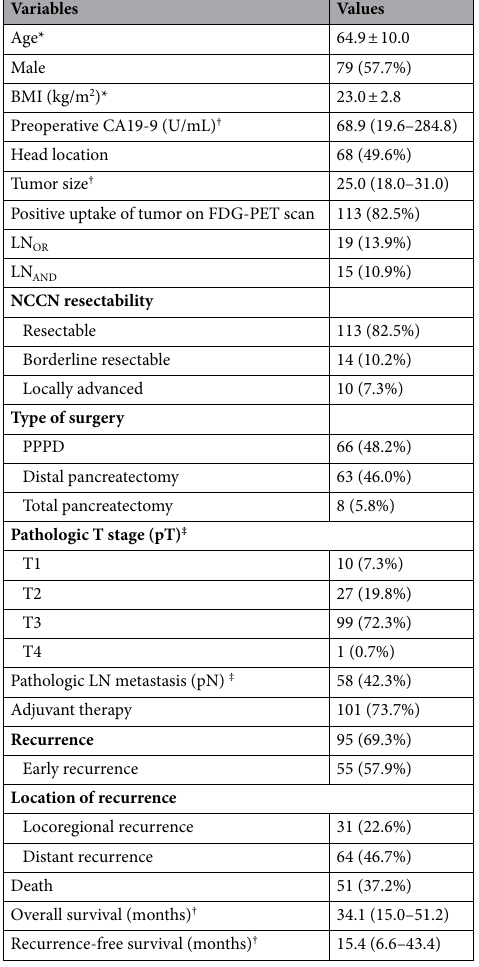
Table 1. Baseline characteristics of the study population. Data are presented as numbers (%) unless otherwise indicated. *Data are presented as mean ± standard deviation. † Data are presented as median (1st quartile–3rd quartile). ‡ TNM staging according to the 8th edition of the American Joint Committee on Cancer (AJCC)/ Union for International Cancer Control (UICC) TNM staging system. BMI , body mass index; CA19-9 , carbohydrate antigen 19-9; FDG-PET , 18 F-fluoro-2-deoxyglucose-positron emission tomography; LN OR , regional LN metastasis on preoperative CT or FDG-PET scans; LN AND , regional LN metastasis on preoperative CT and FDG-PET scans; NCCN , National Comprehensive Cancer Network; PPPD , pylorus-preserving